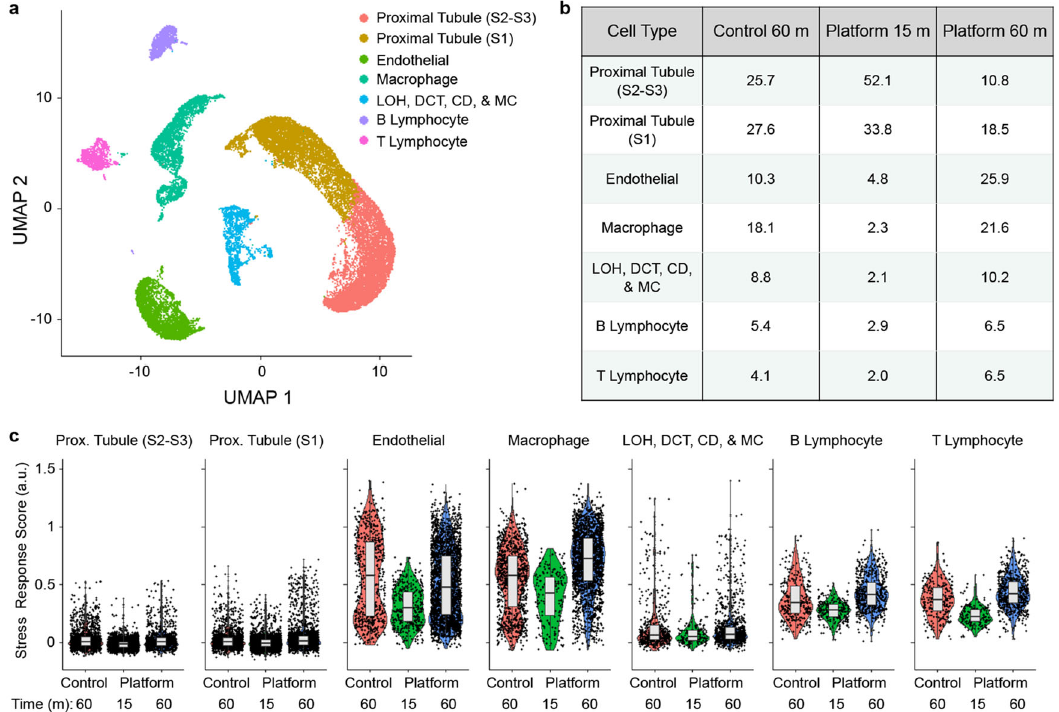
Fig. 4 scRNA-seq of murine kidney ( n = 1). Cell suspensions obtained from the micro fl uidic platform at 15 and 60 min intervals, as well as the 60 min control, were sorted by FACS to remove dead cells and debris, loaded onto a 10X Chromium chip, and sequenced at >50,000 reads/cell. a UMAP displaying seven cell clusters that correspond to two different proximal tubule subtypes, endothelial cells, macrophages, B lymphocytes, and T lymphocytes. The seventh cluster contained a mixed population corresponding to distal convoluted tubules (DCT), loop of Henle (LOH), collecting duct (CD), and mesangial cells (MC). b Population distributions for each cell cluster and processing condition. Proximal tubules were predominantly eluted from the micro fl uidic platform in the 15 min interval, while endothelial cells and macrophages were enriched in the 60 min interval. c Stress response scores, displayed in violin plots, were generally lower for the 15 min device interval. Horizontal line depicts median and edges of box depict 1 st and 3 rd